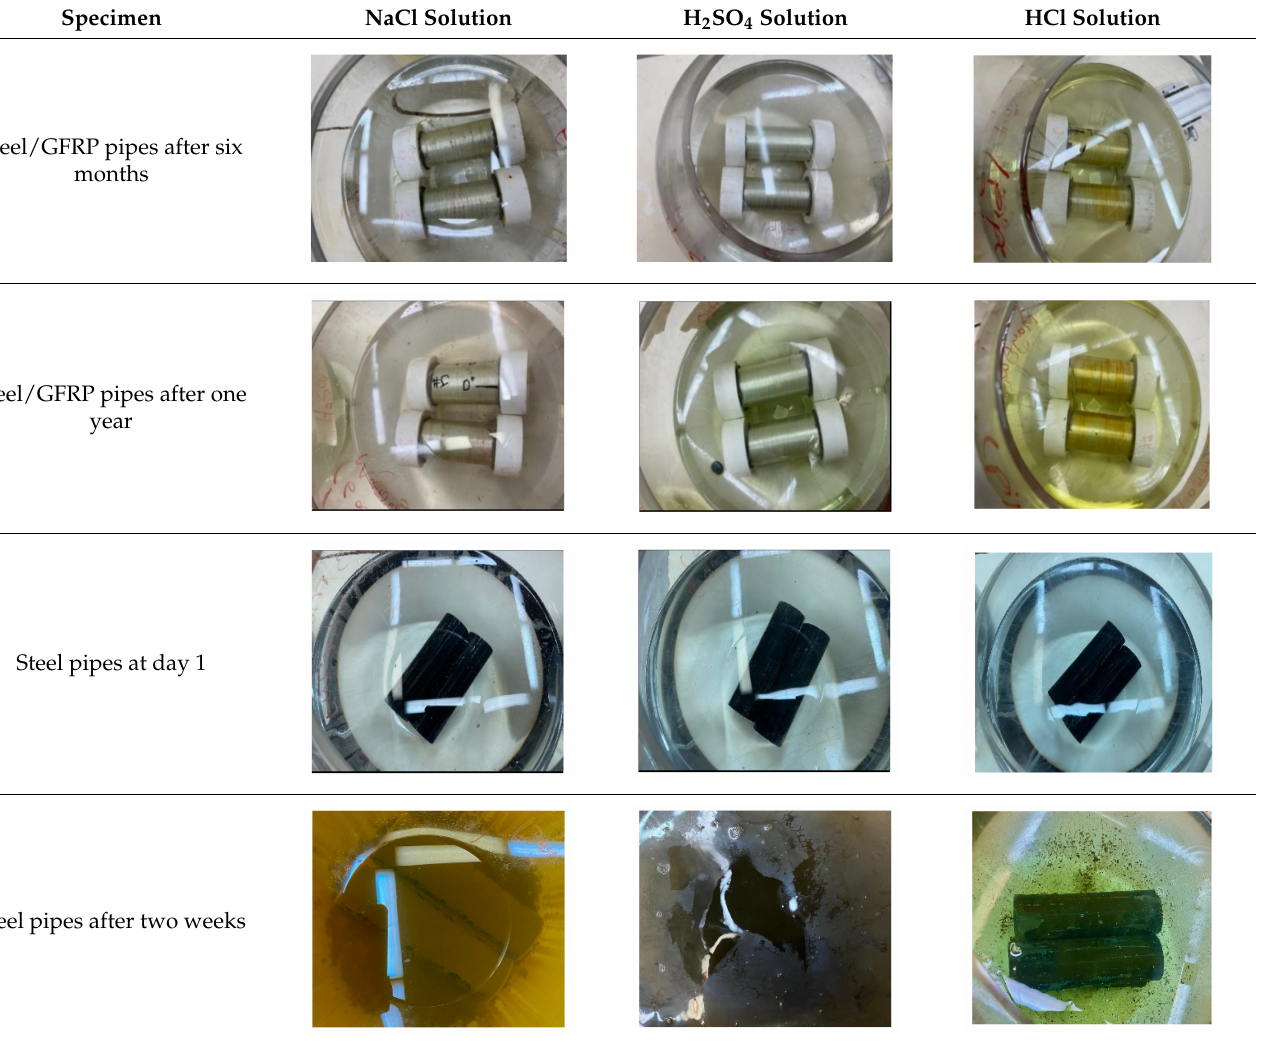
Table 4. Photos for immersion test containers for all the